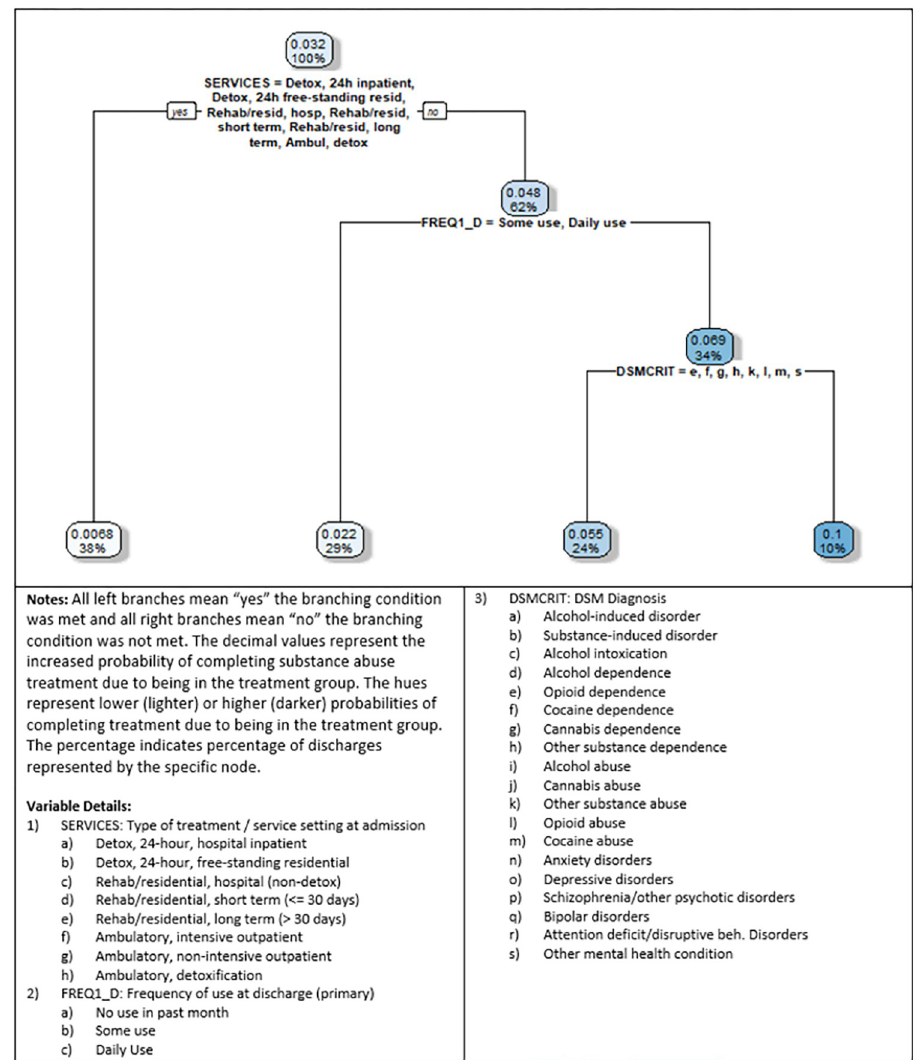
Fig 4. No co-occurring mental health disorder decision tree (P 1i = no co-occurring mental health disorder). The nodes in the tree represent the increased (or decreased) probability of completing treat- ment successfully when one does not have co-occurring substance use and mental health dis- orders. Overall, all the probabilities are positive, suggesting that one is more likely to successfully complete treatment if not also diagnosed with a mental health disorder. The high- est probability of 10% (representing 10% of the sample) is for the subgroup of those discharged from ambulatory, outpatient services (either intensive or non-intensive), have not used in the past month, and with primary a DSMCRIT diagnosis of a (alcohol-induced disorder), b (sub- stance-induced disorder), c (alcohol intoxication), d (alcohol dependence), i (alcohol abuse), j (cannabis abuse), n (anxiety disorders), o (depressive disorders), p (schizophrenia/other psy- chotic disorders), q (bipolar disorders), or r (attention deficit/disruptive behavior Disorders). We note that this probability (10.0%) is the highest observed in this study (when > 1% of the sample is represented). We also note that even higher up in the tree, for the node with a 4.8% probability representing 62% of the sample (which is for those discharged from an ambulatory